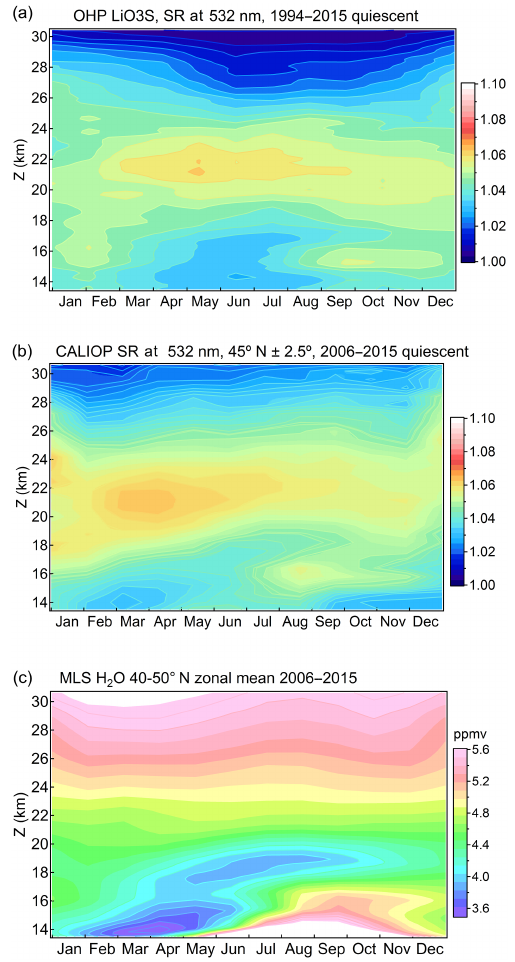
Figure 7. Climatological month–altitude sections of (a) SR from OHP LiO3S lidar for volcanically quiescent periods over the en- tire measurement time span (1994–2015); (b) zonal-mean SR at 45 ◦ N ± 2.5 ◦ from CALIOP, June 2006–September 2015 for vol- canically quiescent periods (Table 2); (c) zonal mean water vapor at 40–50 ◦ N from MLS, June 2006–September 2015.